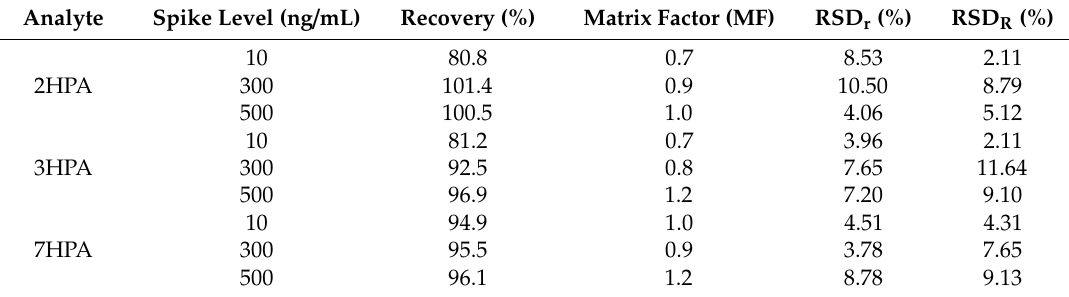
Table 3. Accuracy (recovery %), matrix factor (MF), and precision data (RSD %) in the spiked milk